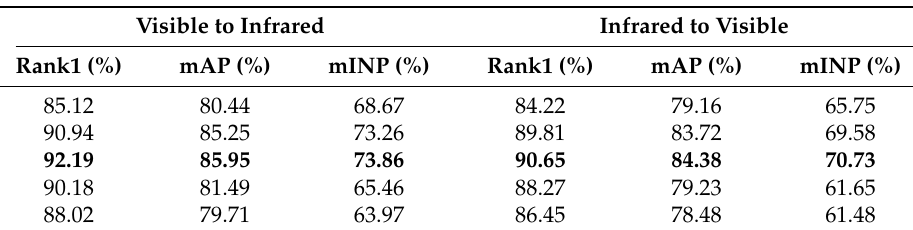
Figure 3. The CMC curves in different MMFSD’s weights (i.e., λ in Equation (9)) on SYSU-MM01 dataset of ( a ) all-search mode and ( b ) indoor-search mode. Table 4. The performance comparison of using different weights of MMFSD loss function (i.e., λ in Equation (9)) on the RegDB dataset.